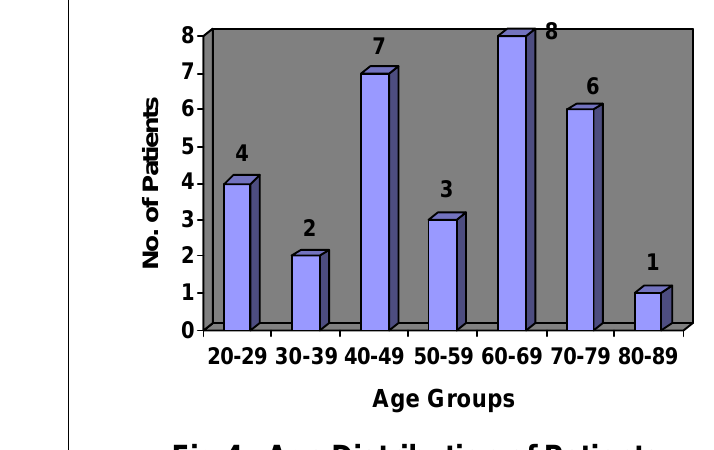
Fig.4 : Age Distribution of